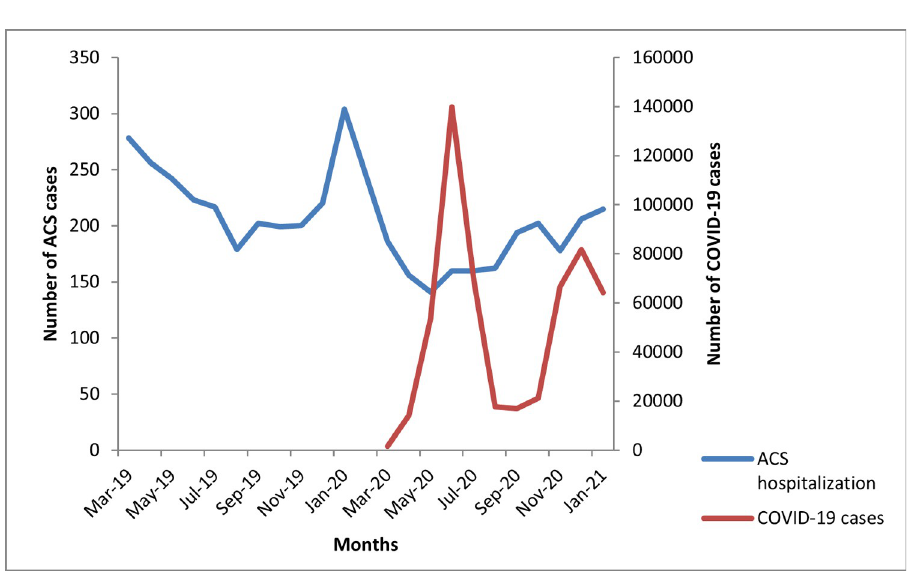
Fig 1. ACS cases between pre-pandemic vs. pandemic months and number of COVID-19 cases in Pakistan.